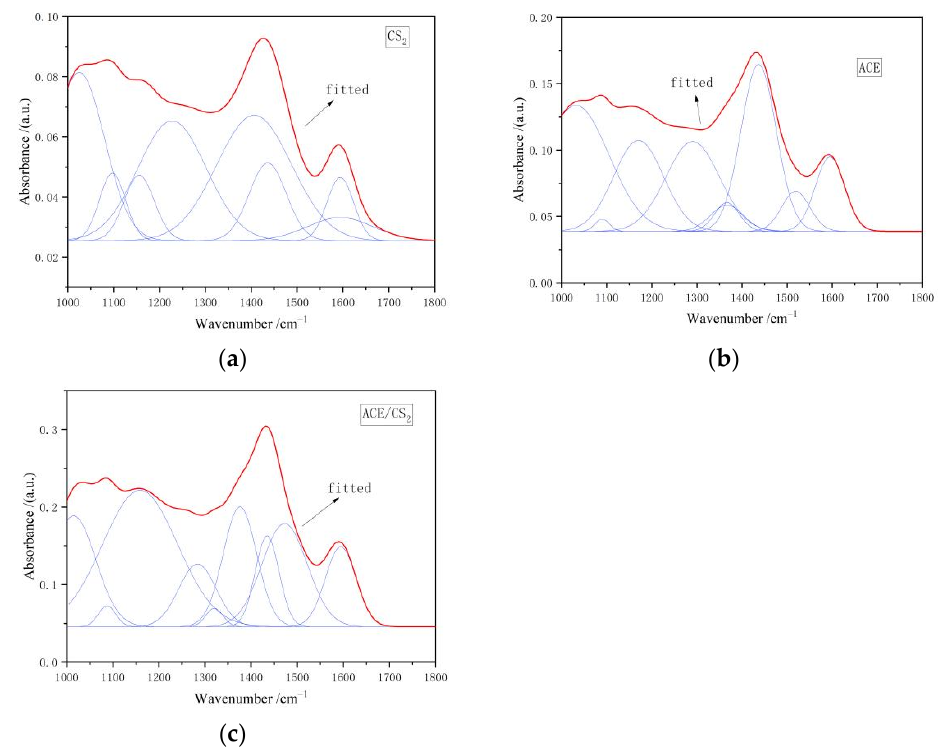
Figure 3. Infrared spectra of extracts in the 1000–1800 cm − 1 range. (( a ) is the carbon disulphide fit, ( b ) is the acetone fit and ( c ) is the mixed solvent fit. The red line is the fitted curve and the blue line is the sub peak.) Table 3. Infrared spectra of three solvent extracts 1000–1800 cm − 1 split peak fi tt ing ratio of each absorption peak area [14].